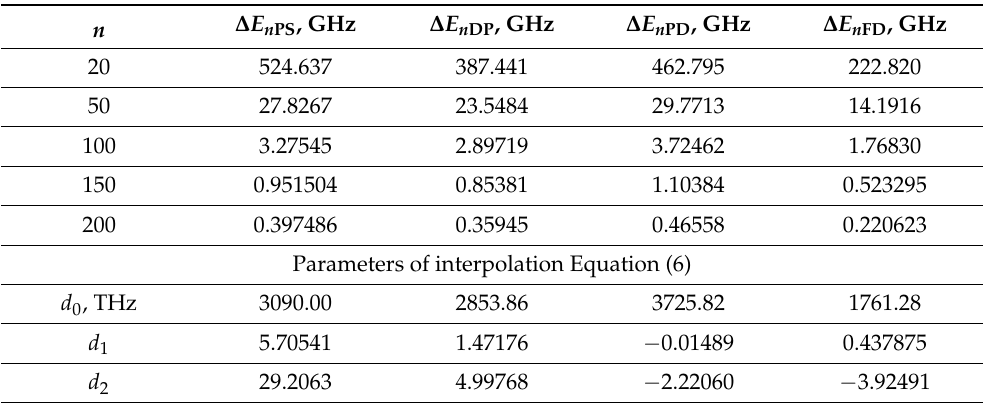
∆ E = E − E n DP n D 5/2 n P 3/2 ; from state